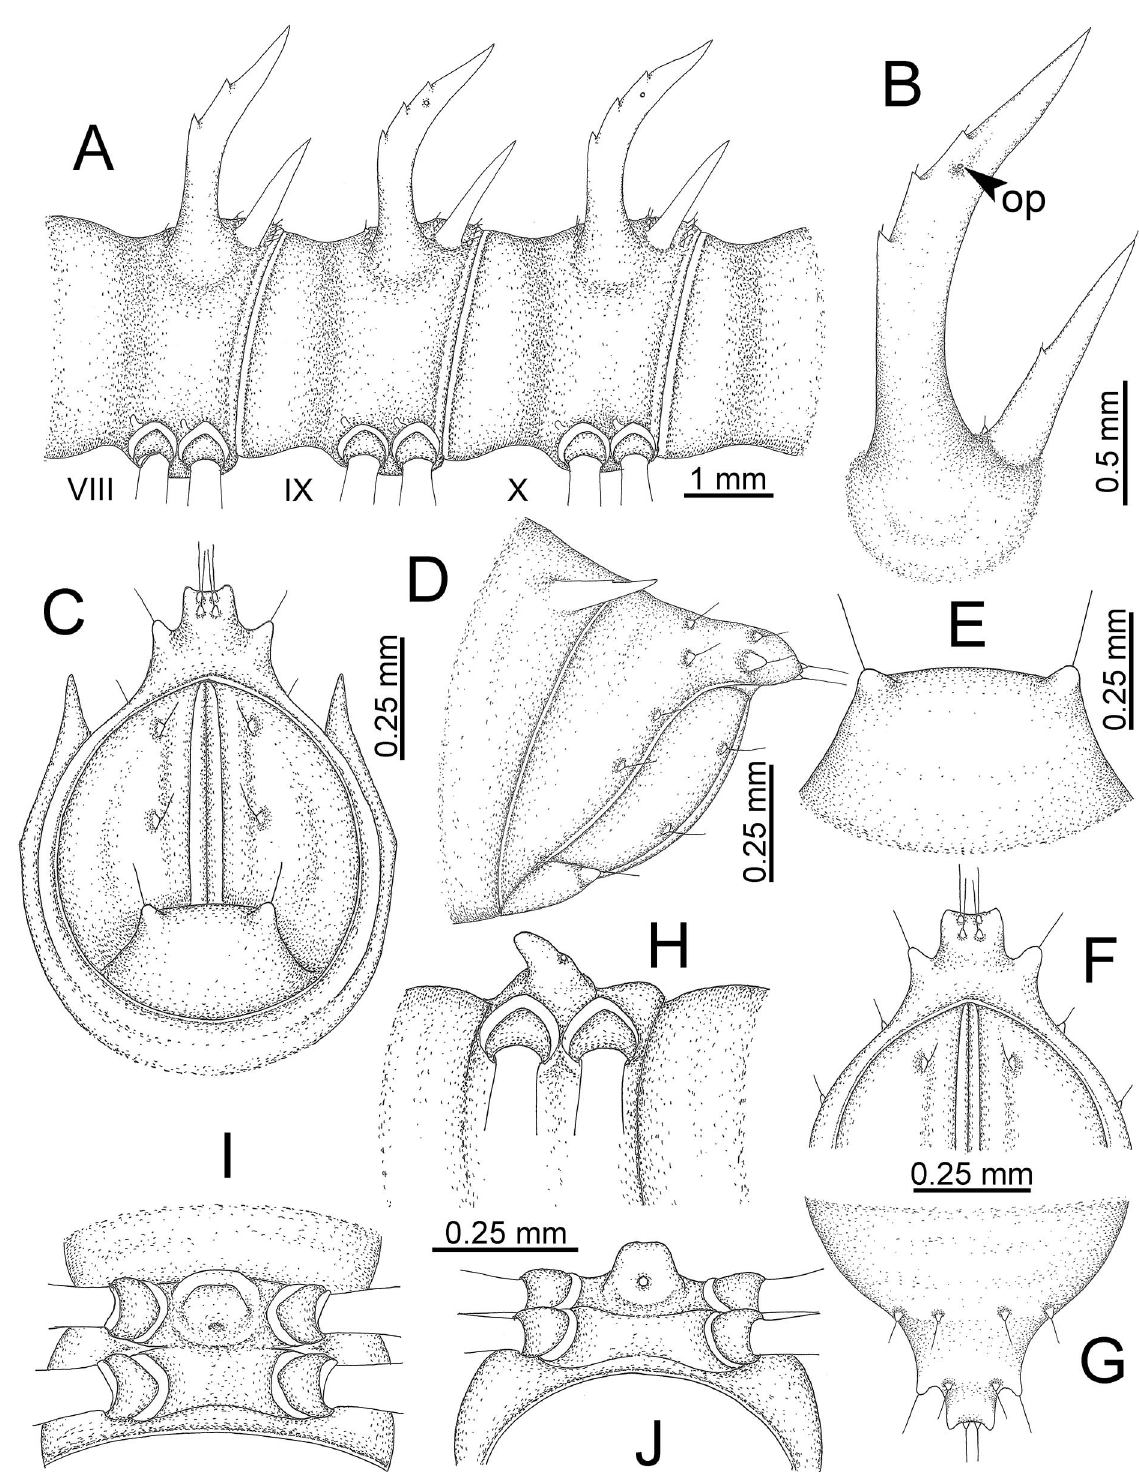
Fig. 11. Gigaxytes gigas (Golovatch & Enghoff, 1994) gen. et comb. nov., ♂, specimen from Wat Tham Sue (Tiger Cave). A . Body rings 8–10. B . Paraterga of ring 10 (arrowhead points to ozopore). C – D . Last ring and telson. E . Hypoproct. F – G . Epiproct. H – J . Sternal lobe between coxae